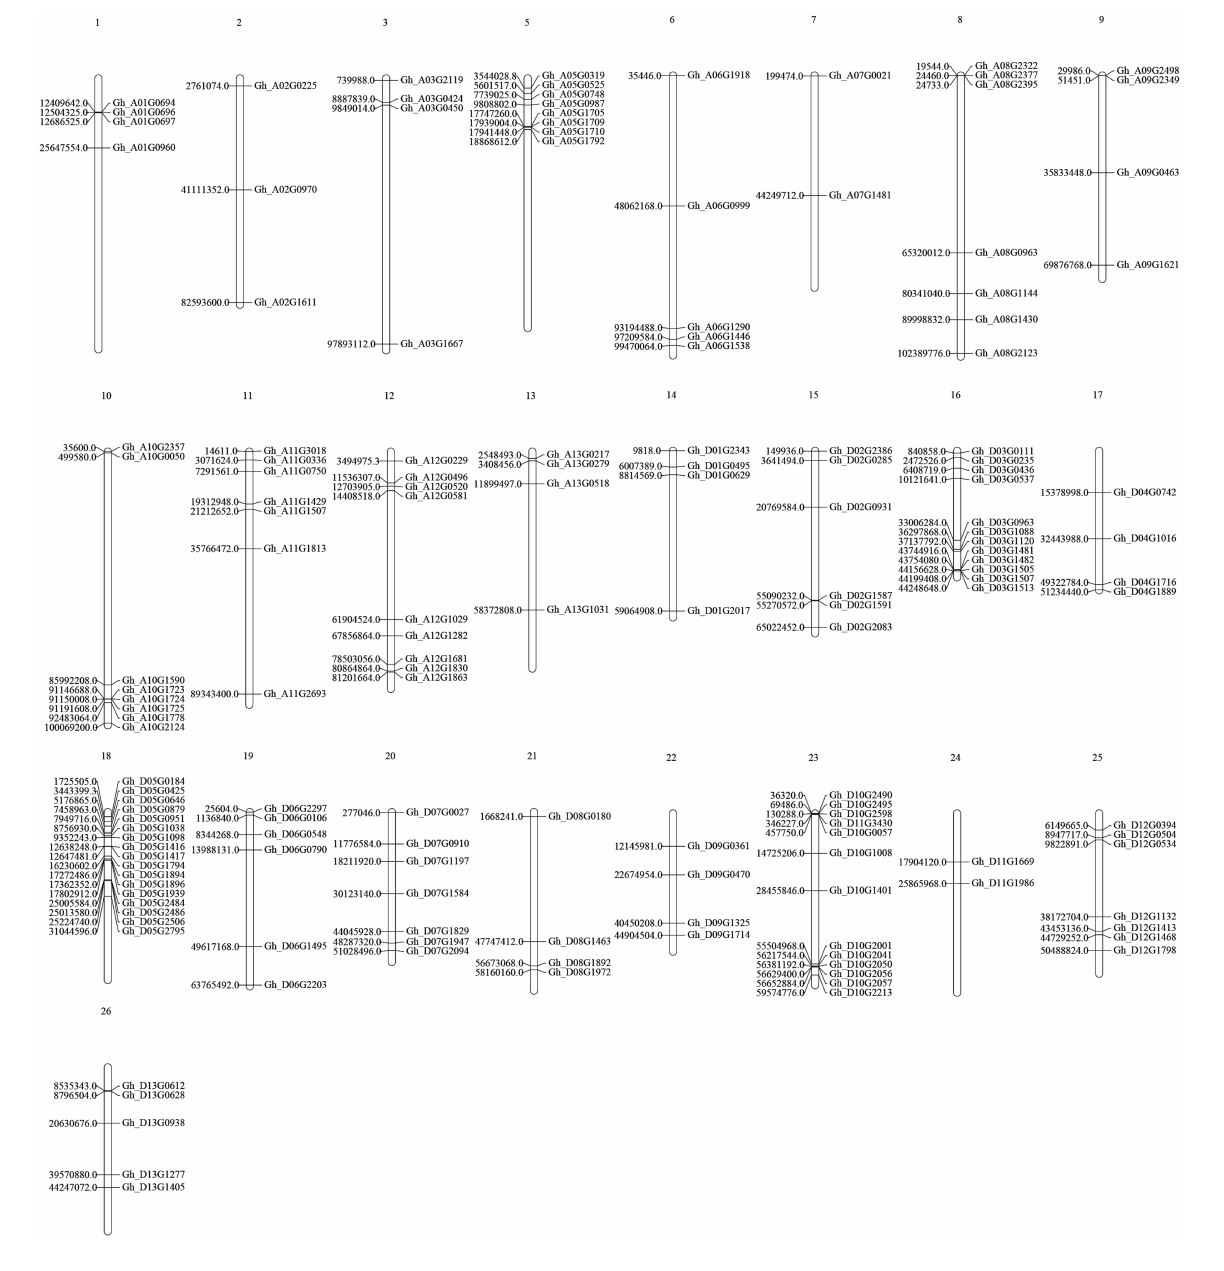
Figure 5 . There were many double duplications of genes among the AD subgroups. Furthermore, four genes on chromosomes A05 and D05 were